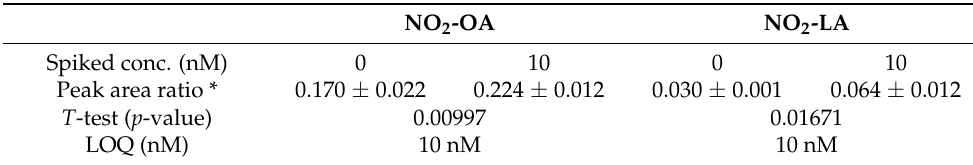
Figure 6. Calibration curves of NO 2 -OA and NO 2 -LA in pooled plasma, in the presence of HDA as an internal standard, to assess linearity over a concentration range of 0–60 nM spiked NO 2 -FAs. Each calibration point is the average of 3 datapoints. Error bars represent a ± standard error of the mean. Table 4. Limits of quantification of NO 2 -OA and NO 2 -LA in plasma, estimated from the lowest statistically significant increase in